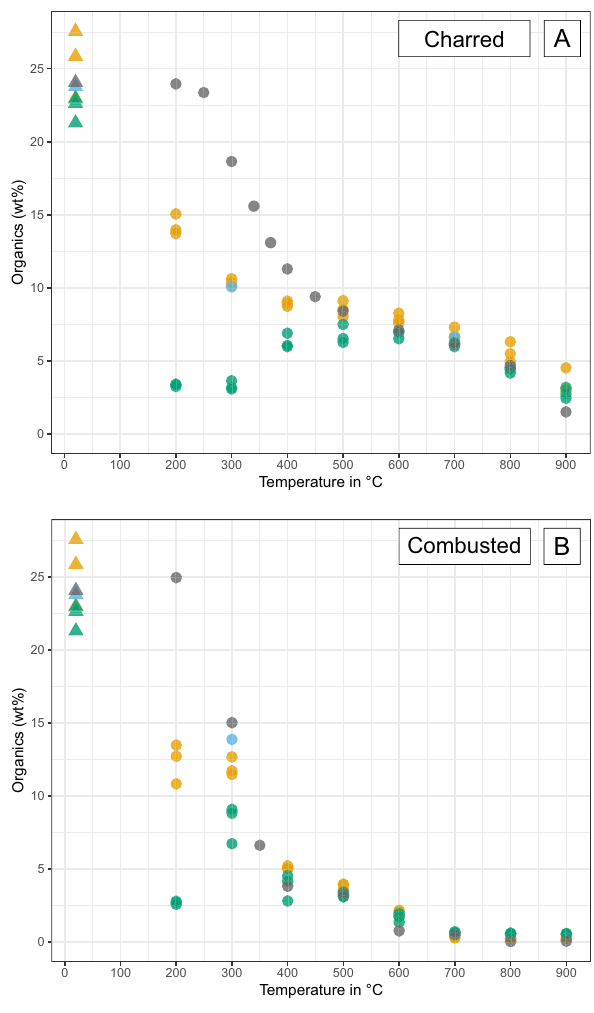
Figure 5. Graphs showing the variation in organic content (wt%) in charred ( A ) and combusted ( B ) bone, as measured by TGA, as a result of pH exposure. Triangles = unheated bone, circles = heated bone, grey = untreated samples, yellow = pH 3 samples, blue = pH 7 samples, green = pH 12